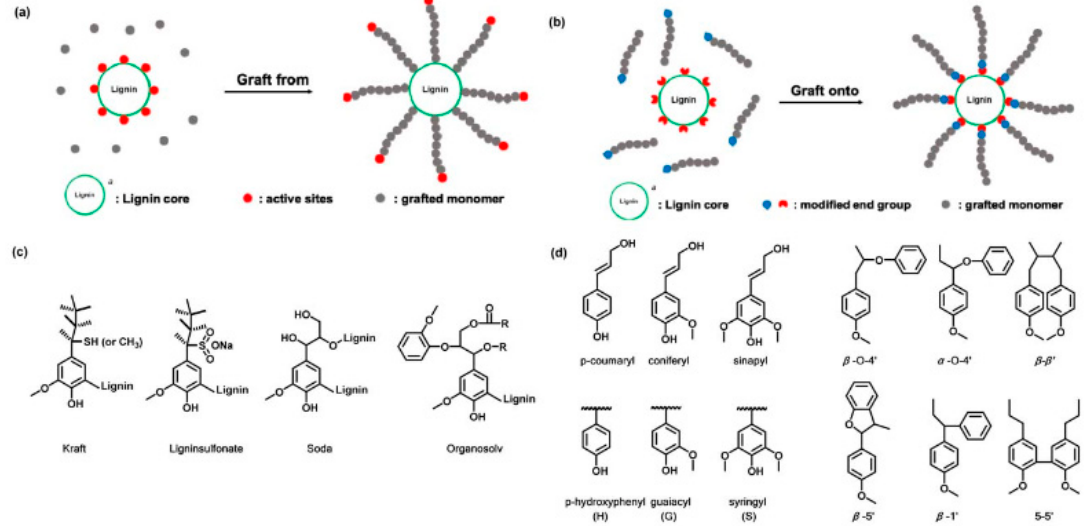
Figure 1. ( a ) An illustration of the graft-from synthesis of lignin copolymers; ( b ) a demonstration of graft-onto methods; ( c ) industrial lignin products; ( d ) sinapyl alcohol, coniferyl alcohol, and p-coumaryl alcohol units [16].